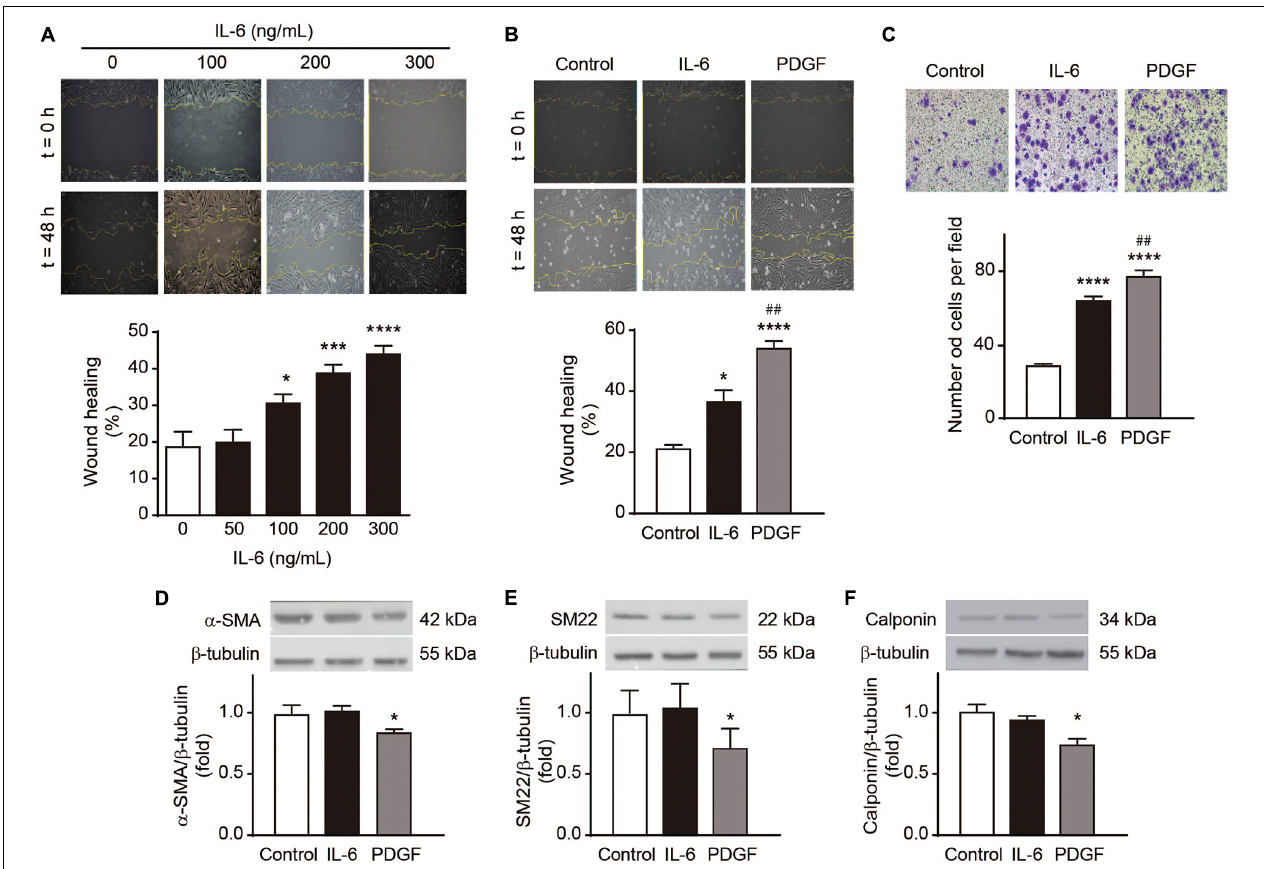
FIGURE 4 | Interleukin-6 (IL-6) induces A7r5 vascular smooth muscle cell migration. (A) A7r5 VSMCs were treated with 0, 100, 200, and 300 ng/mL IL-6, and cell migration was assessed by wound healing assay. (B,C) A7r5 VSMCs were treated with 300 ng/mL IL-6 or 20 ng/mL PDGF-BB, and cell migration was assessed by wound healing assay (B) or Transwell assay (C) . Wound healing (%) after 24 h and migrated cells per field in Transwell chamber after 4 h were measured using ImageJ software ( n = 5). (D–F) A7r5 VSMCs were treated with 300 ng/mL IL-6 or 20 ng/mL PDGF-BB for 24 h. α -Smooth muscle actin ( α -SMA) (D) , SM22 (E) , and calponin (F) levels were determined by Western blot ( n = 5). β -tubulin was used as a loading control. Upper panels are representative images. Lower panels are measurements. Data represent mean ± SEM and were analyzed using one-way ANOVA followed by Holm-Sidak’s multiple comparisons test. * p < 0.05, *** p < 0.001, **** p < 0.0001 vs. control; ## p < 0.01 vs.